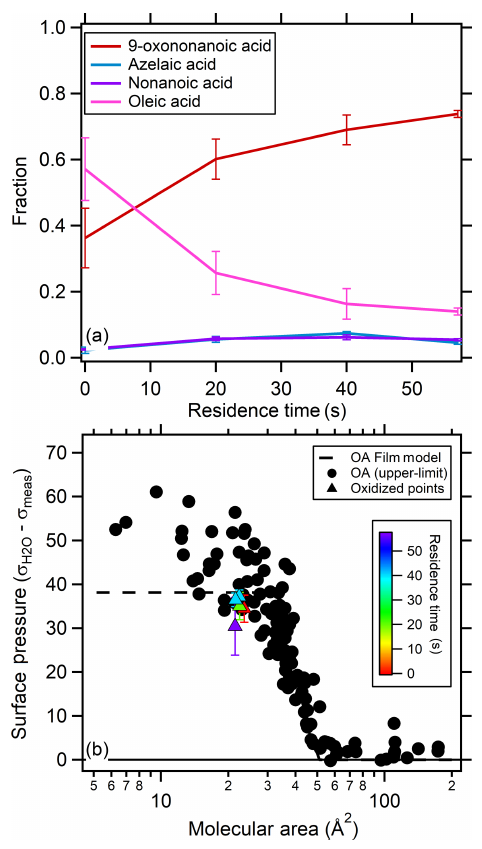
Figure 6. (a) Fractional contribution of oleic acid and oxidation products as a function of residence time. (b) Surface pressures as a function of molecular area for oxidized oleic-acid-coated NaCl particles colored by residence time (triangles). Upper-limit surface pressure estimates (black circles) and film model estimate (dashed black line) for unoxidized oleic-acid-coated NaCl experiments are provided for